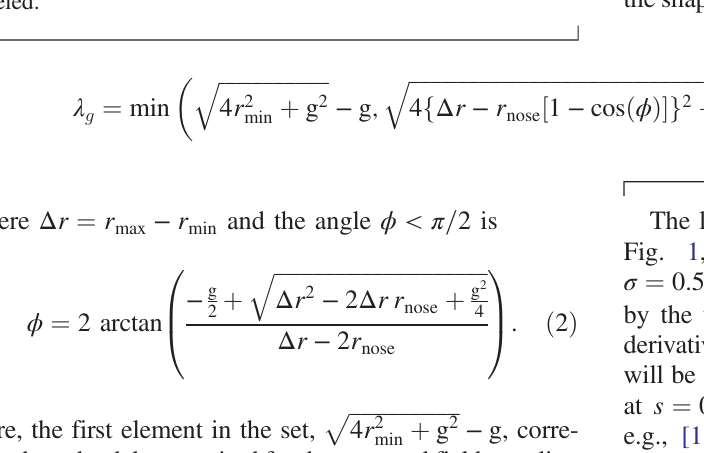
line).FIG. 1. rf cavity geometry with key points and dimensions